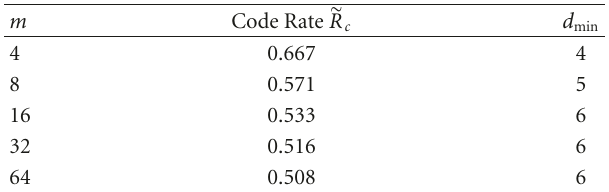
Table 1: Rates and minimum distances of the punctured rate-1 / 2 convolutional